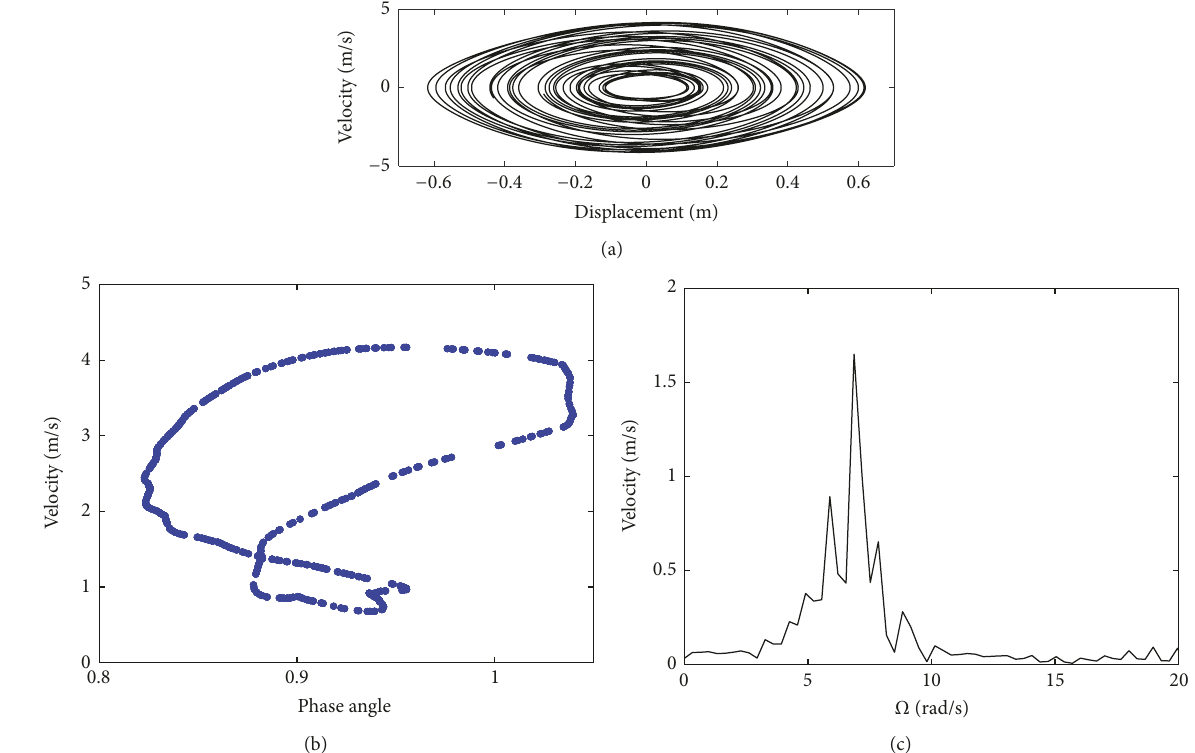
Figure 14: Chaotic motion at Ω = 7.964 rad/s: (a) the phase portrait, (b) Poincar´e map, and (c) the frequency spectrum.